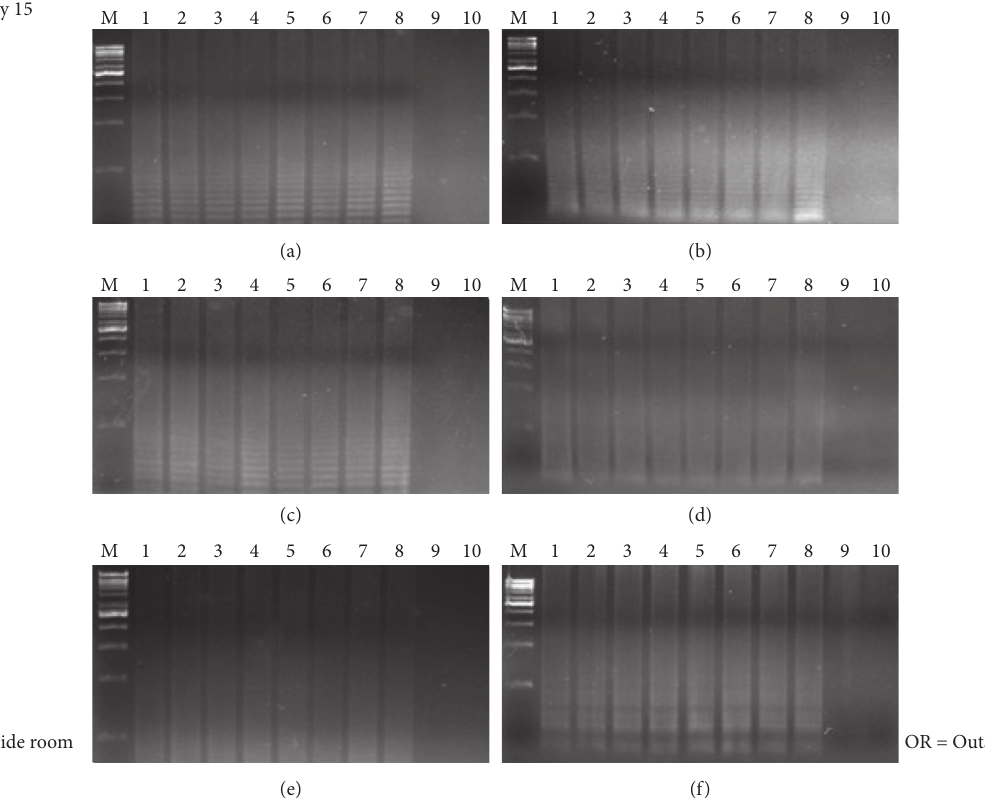
Figure 4: Time course detection of DNA sample stained on different surfaces in day 15. (a), (b) brick, (c), (d) cloth, and (e), (f) tile. M � 1kB DNA ladder, lane 1–9 � male sample 1–8, and lane 9, 10 � female sample